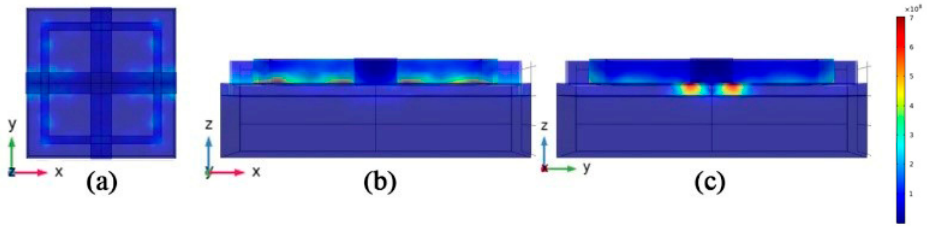
Figure 4. ( a ) top view of the electric field at a frequency of 396 THz. ( b ) Electric field view from the y -axis direction; ( c ) electric field view from the x -axis direction.